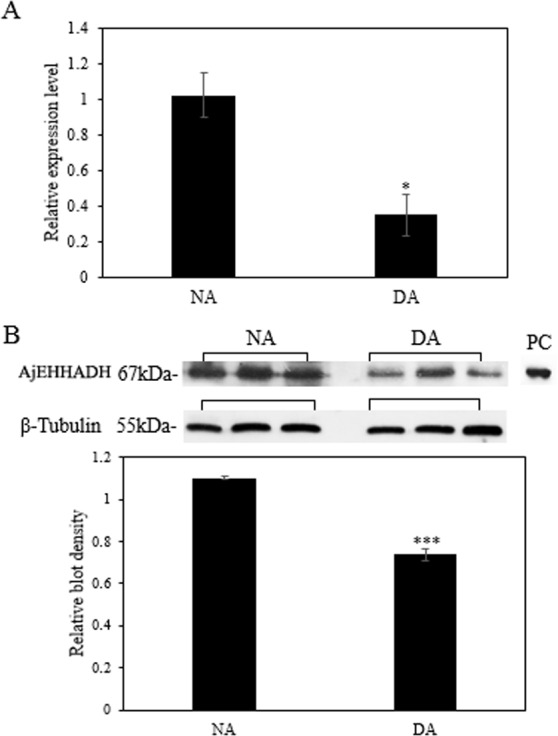
Effect of estivation on the relative expression levels of AjEHHADH.(A) Relative mRNA expression levels of AjEHHADH in the intestine of NA and DA groups respectively. Values were normalized against β-Tubulin. “*” indicates significant statistical differences (P < 0.05). Values are means ± SE (N = 5). (B) Relative protein expression level of AjEHHADH at the NA and DA stages in intestine by Western blot. Representative bands show blot intensity for NA and DA groups. Histograms show normalized expression levels for NA and DA. β-Tubulin was chosen as the internal control. “***” indicates significant differences for NA and DA groups (P < 0.001). Values are means ± SE (N = 4).